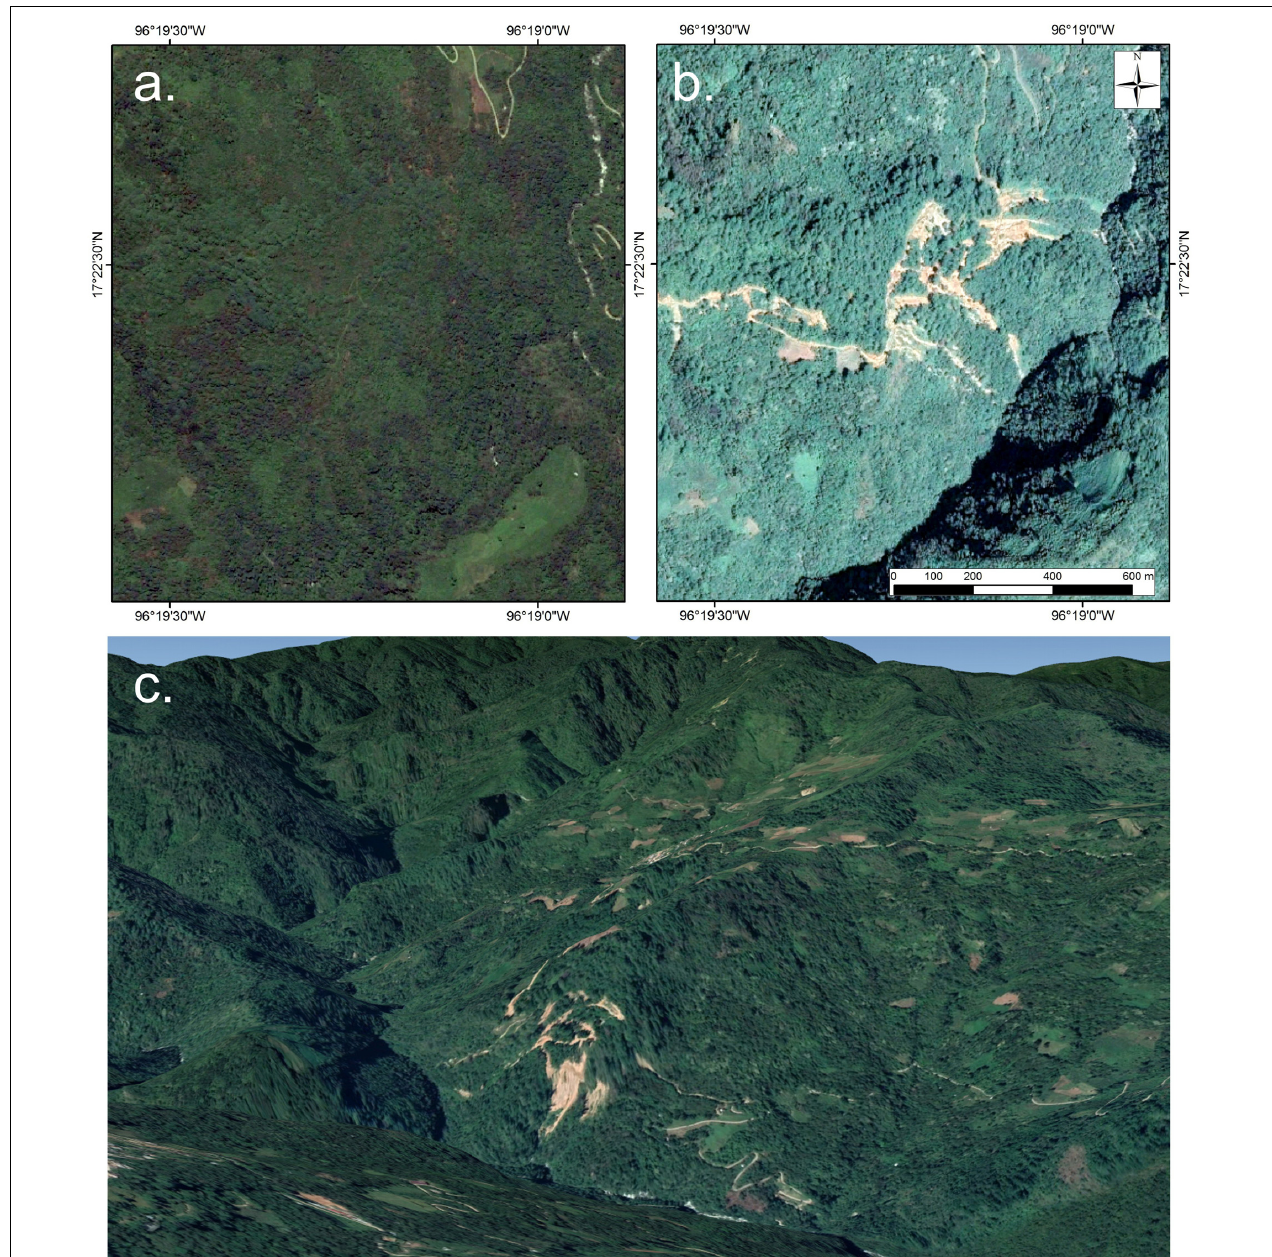
FIGURE 2 | A landslide in Sierra Norte, Oaxaca, Mexico as detected by satellite images (Google Earth R (cid:13) ). (a) Before (2014), and (b,c) after the landslide